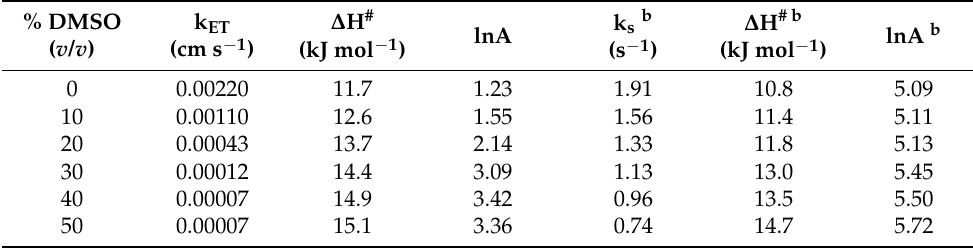
Table 2. Redox kinetics of the M80A mutant of yeast cytc in the presence of increasing DMSO concentration. k ET was measured at 20 ◦ C [ a